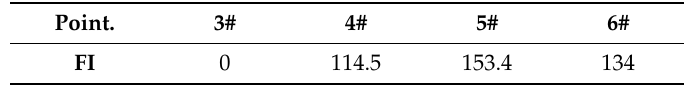
Table 8. Freezing indexes of points inside the subgrade during monitoring period.